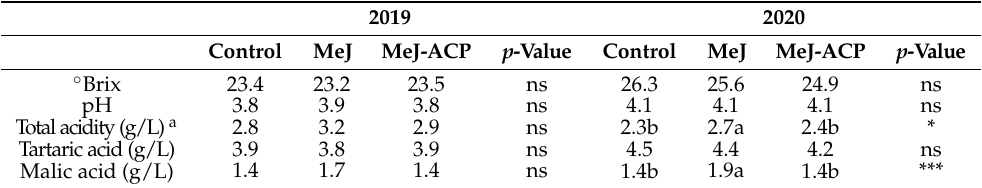
Table 2. Physicochemical parameters of Monastrell must at